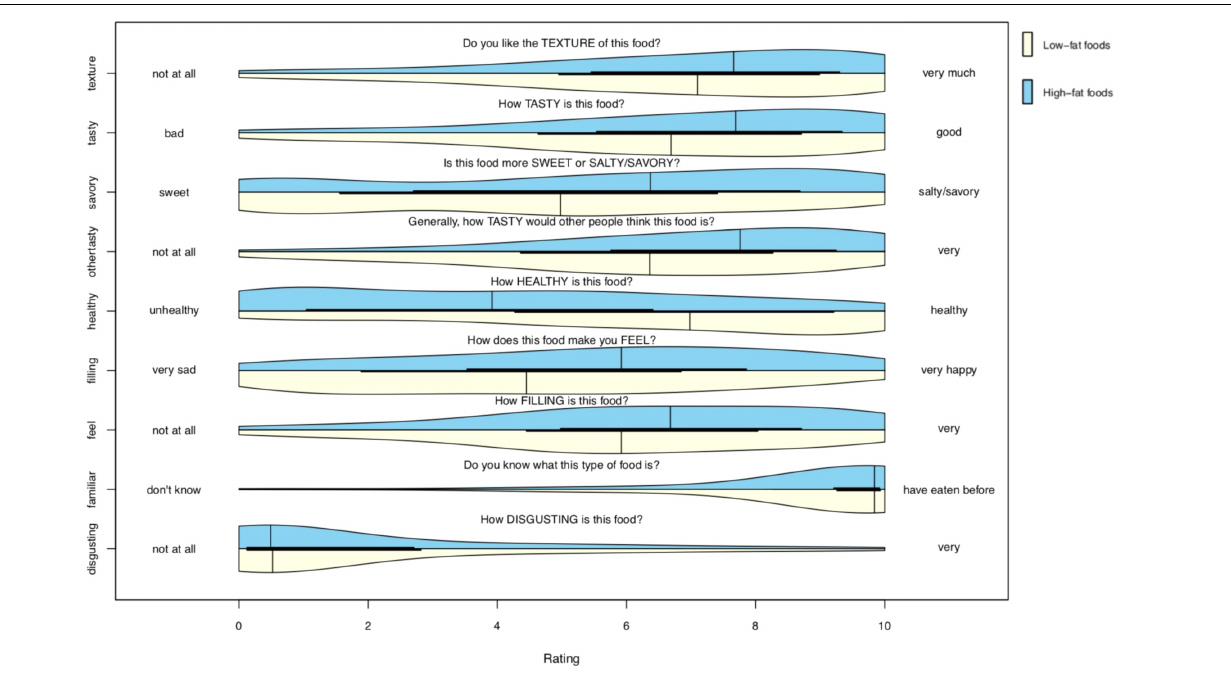
FIGURE 3 | Probability distribution plot of food characteristic ratings. Plots show the distribution of scores for each food characteristic rating across the collection of low-fat (lower/yellow) and high-fat (upper/blue) foods of the stimulus set. Every rating (for each of the 46 foods, from all 1,054 participants) is included. N ratings for low-fat foods = 25,647; n ratings for high-fat foods = 22,862.